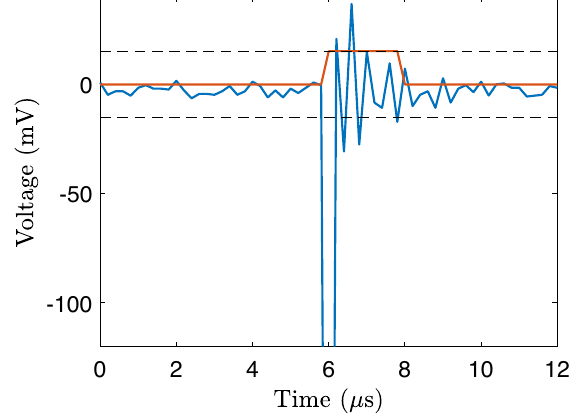
FIG. 10. Dark current signal as a function of time, shown over a period of 12 μ s measured at an electric field of 29 . 2 MV = m in measurement series D. The first peak of the current reaches a value of approximately − 800 mV. The dashed lines represent the event thresholds of 6 σ , and the solid straight line shows how a number of current peaks, caused by ringing, were counted as one